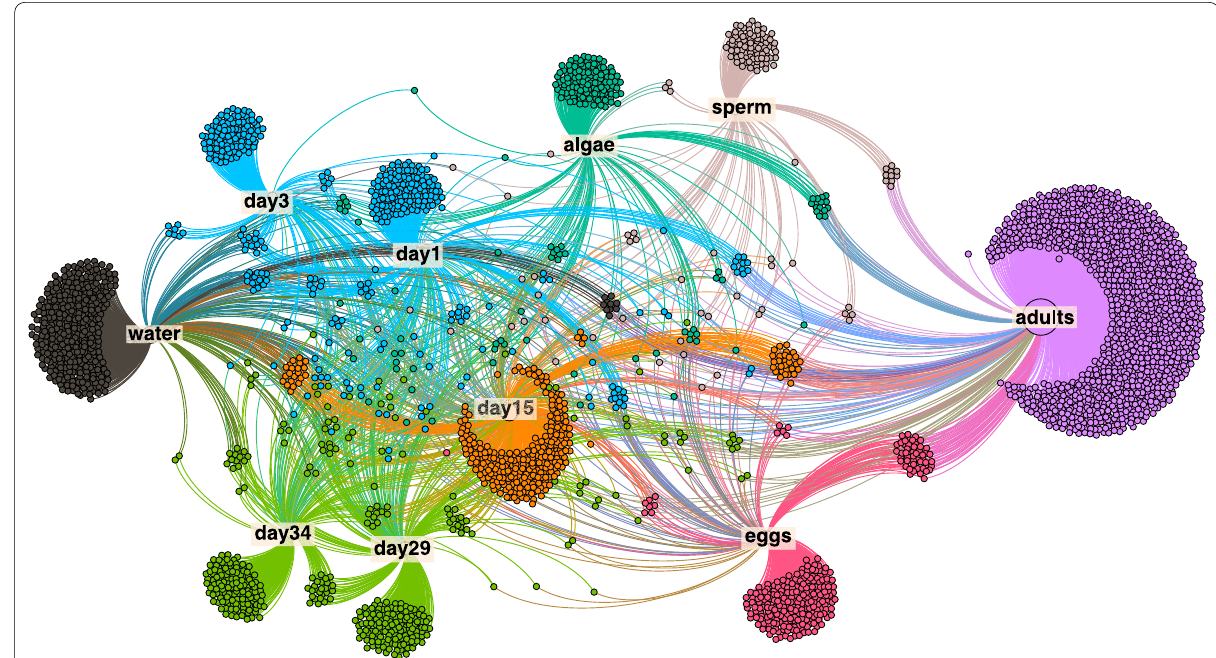
Fig. 3 Force directed network of the ASVs in our data set with a relative abundance > 0.001 ( n connect the ASVs to the sample type they were found in. Colors represent different modules identified in modularity analysis of the